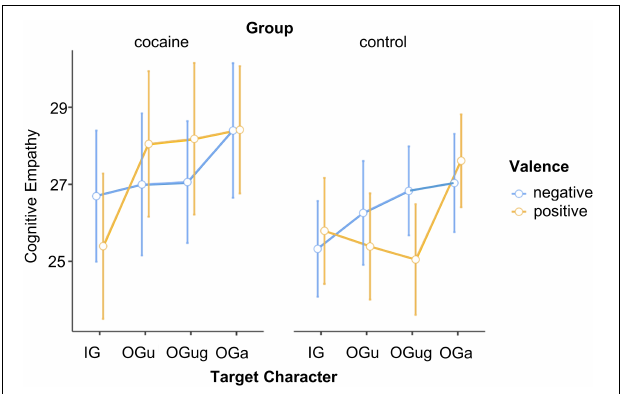
FIGURE 5 | Cognitive empathy expressed for the different social targets. IG, in-group; OG u , out-group use; OG ug , out-group use + gender; OG a , out-group age. Error bars, standard errors.